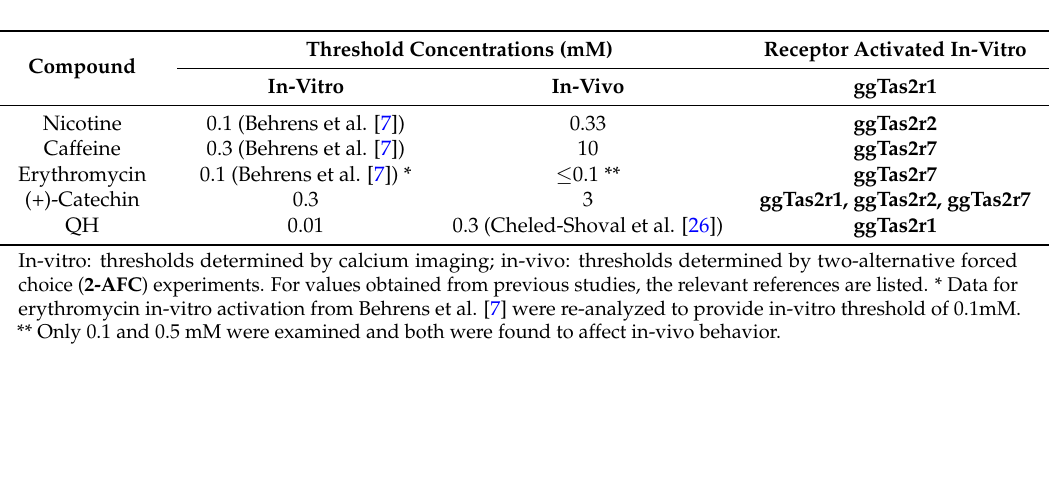
Table 1. In-Vitro and in-Vivo Avoidance Thresholds for